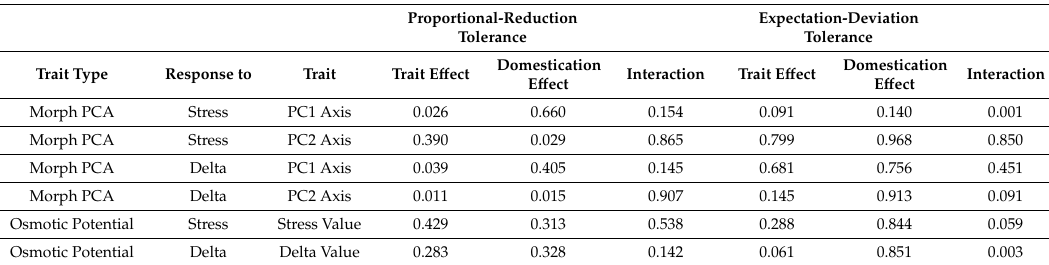
Table2. Associationsoftolerance(proportionalreductiontoleranceandexpectation-deviation-tolerance) with traits (PC1 and PC2 scores from PCAs of size-independent morphological traits (Morph PCA), and osmotic potential) and domestication status, for traits reported as measured in the salinity stress treatment (stress) and as the di ff erence between the control and salinity treatment